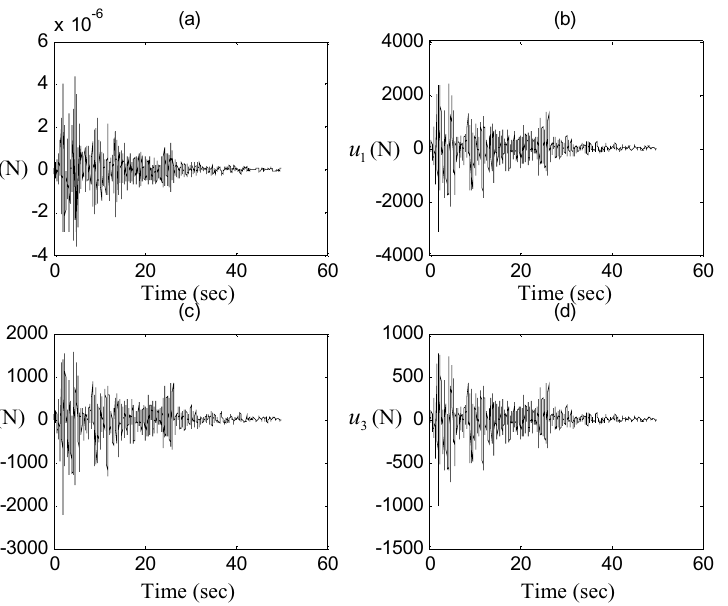
Fig. 4. Force simulations of active LQR-controlled structure by confinement. (a) Passive element u r 1 = u p ; (b) First mass u r 2 = u 1 ; (c) Second mass u r 3 = u 2 − u 1 ; (d) Third mass u r 4 = u 3 − u 2 .